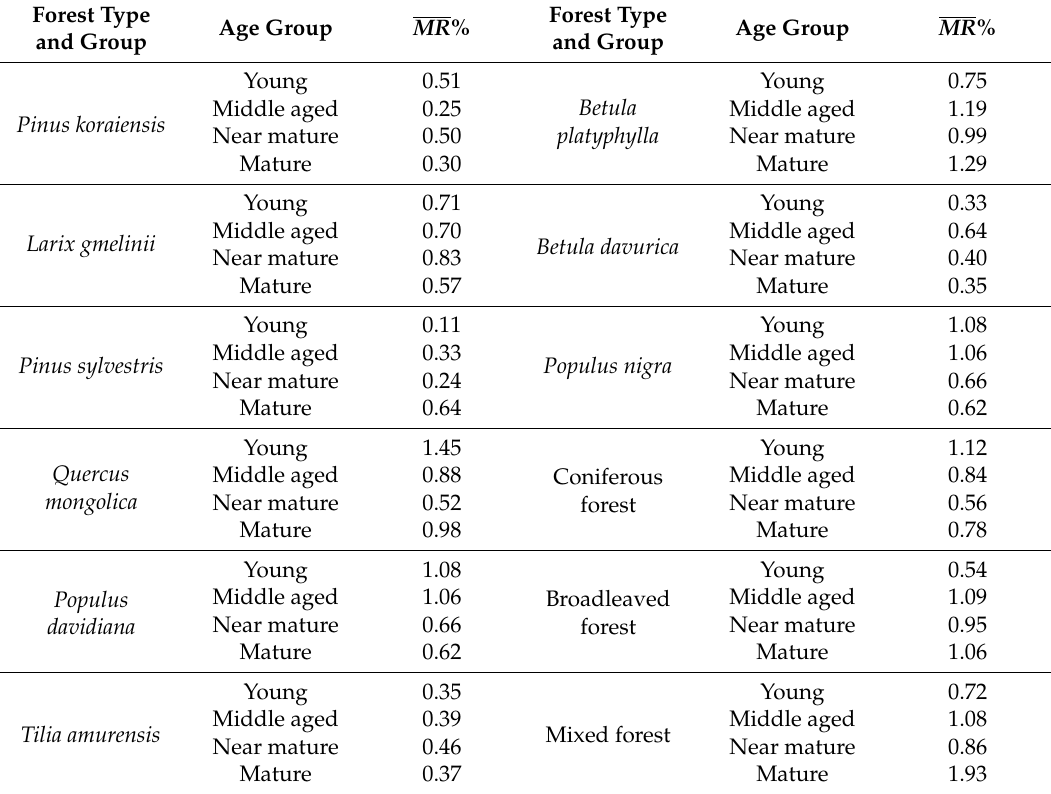
Table 3. The average mortality rate in percent volume change for nine forest types and three forest type